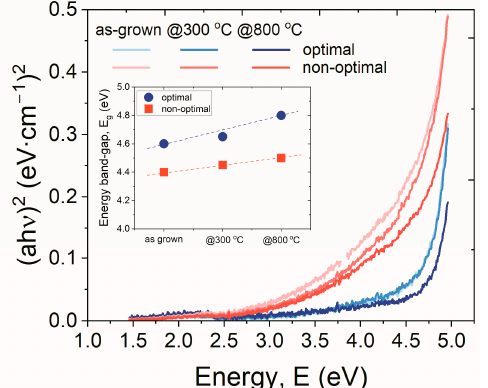
Figure 8. Variation of Tauc’ plots of HfO x N y thin- fi lms. Inset: the extracted band-gap ( E g ) value, based on the relation ( α h ν ) 2 versus h ν of particular hafnium oxynitride fi lms.